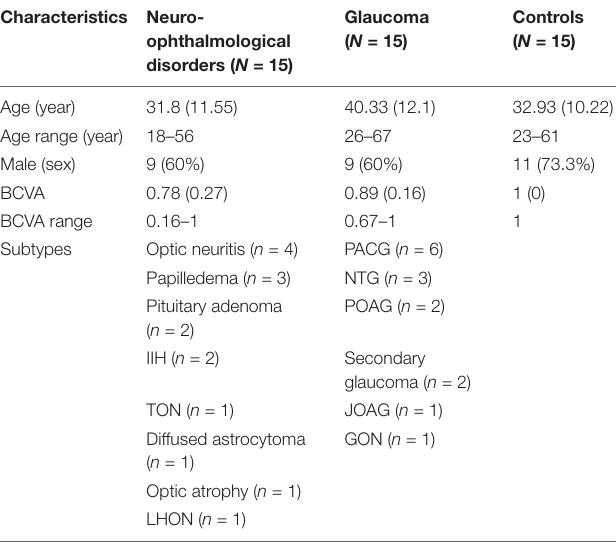
TABLE 1 | Demographics and clinical characteristics of the